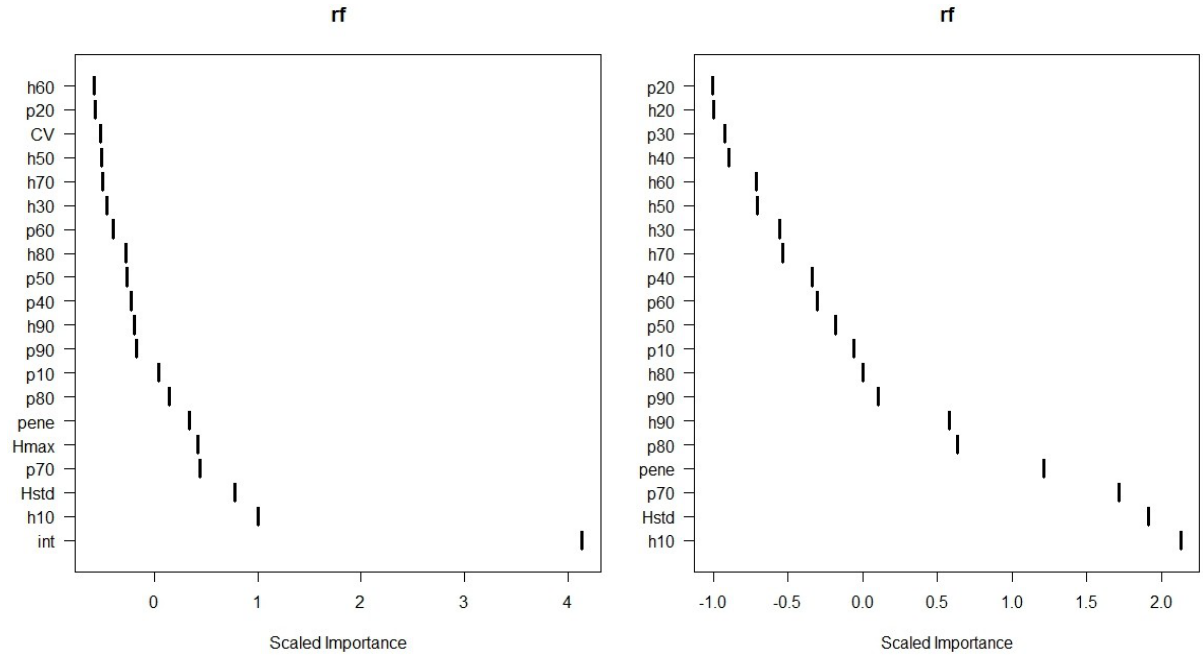
Figure 2. Scaled importance of top 20 ALS metrics in Random Forest (RF) run for classification of defoliation (classification scheme DEF1). All ALS metrics on left and ALS metrics included on right.